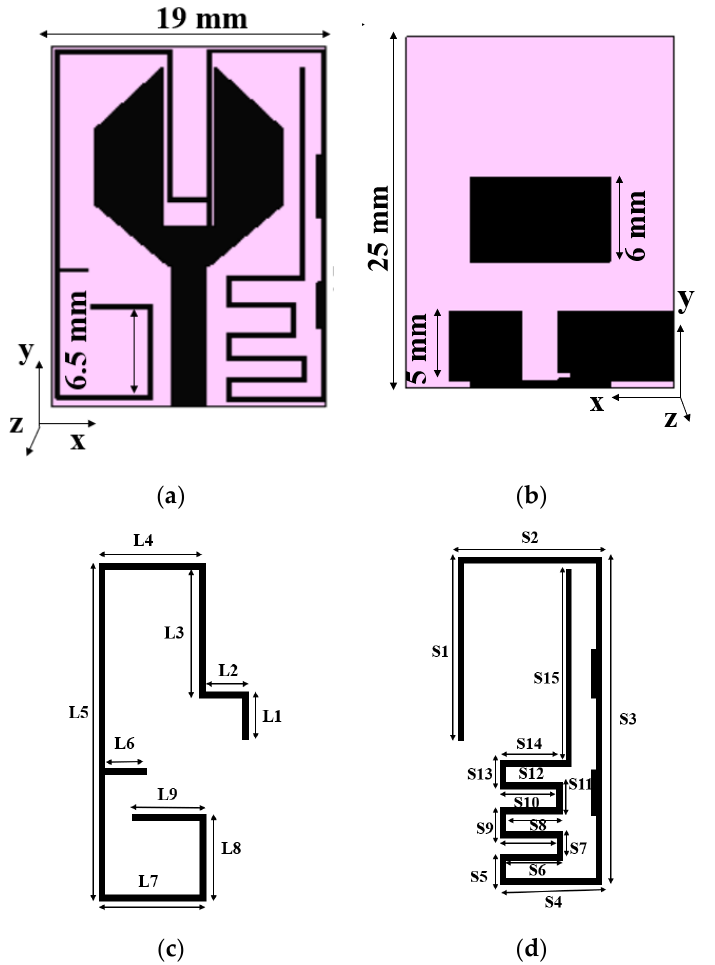
Figure 1. Layout of the antenna element: ( a ) front view, ( b ) back view, ( c ) G-shaped stub, 2.4 GHz, ( d ) E-shaped stub, 1.5 GHz.